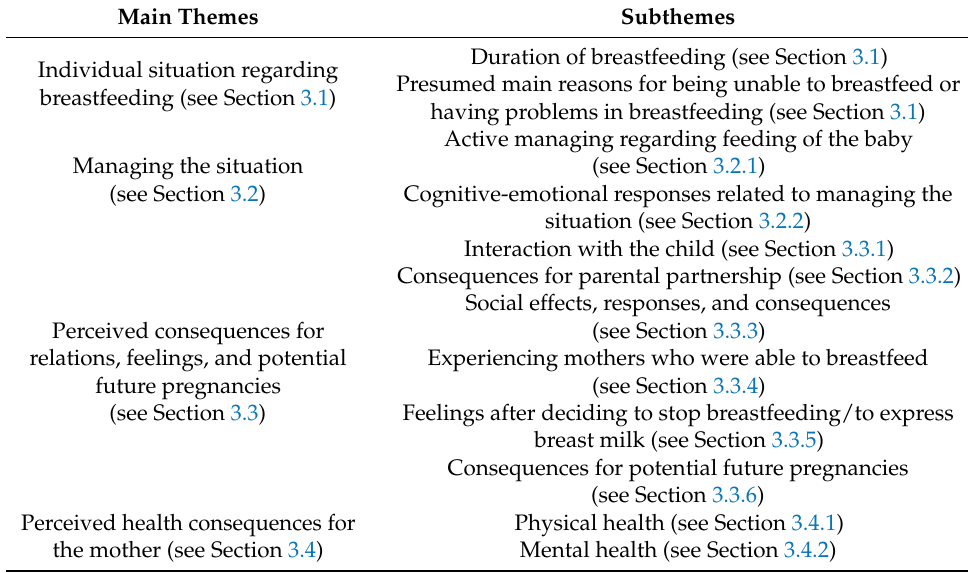
Table 2. Mean themes and subthemes extracted from the